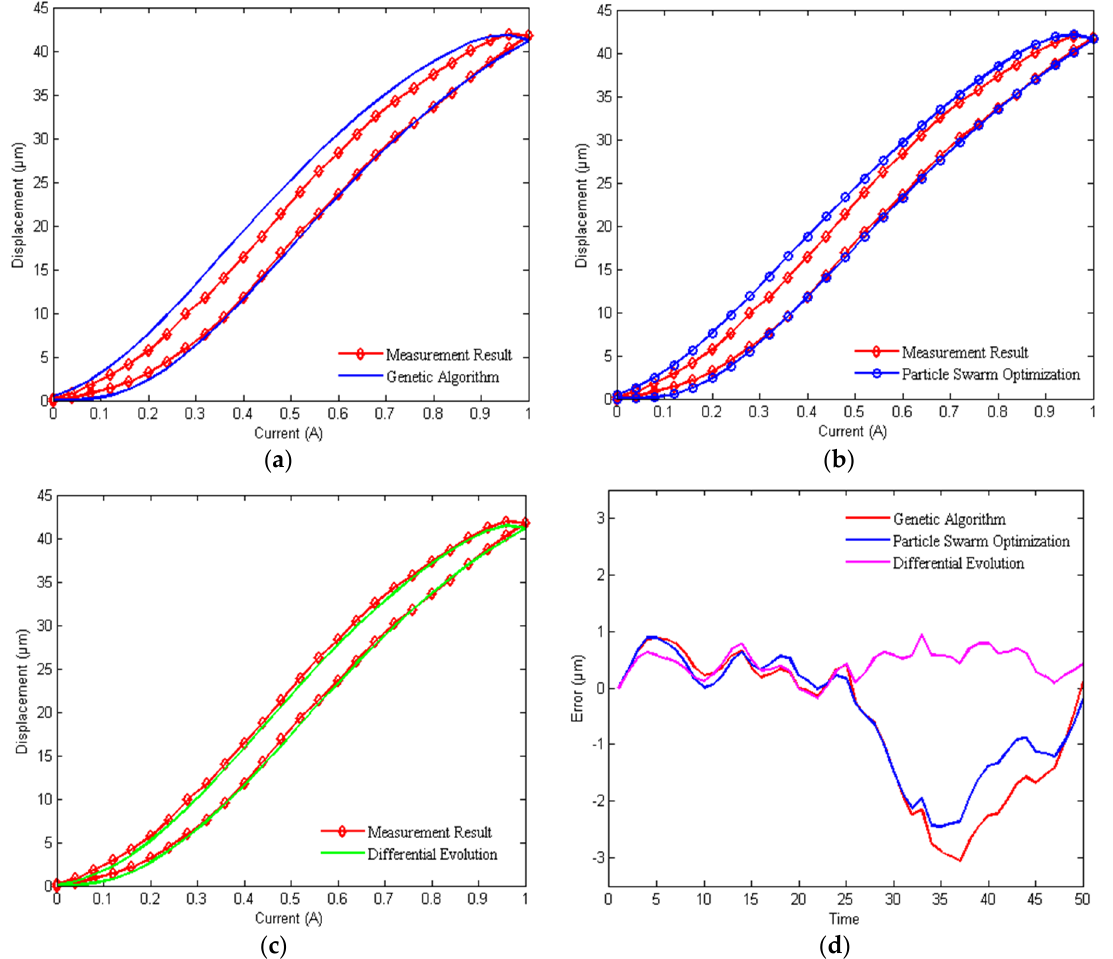
Figure 7. Comparison of simulation results and experimental results: ( a ) Measurement result and Genetic Algorithm; ( b ) Measurement result and Particle Swarm Optimization; ( c ) Measurement Result and Differential Evolution; ( d ) the time of Genetic Algorithm, Particle Swarm Optimization, and Differential Evolution.